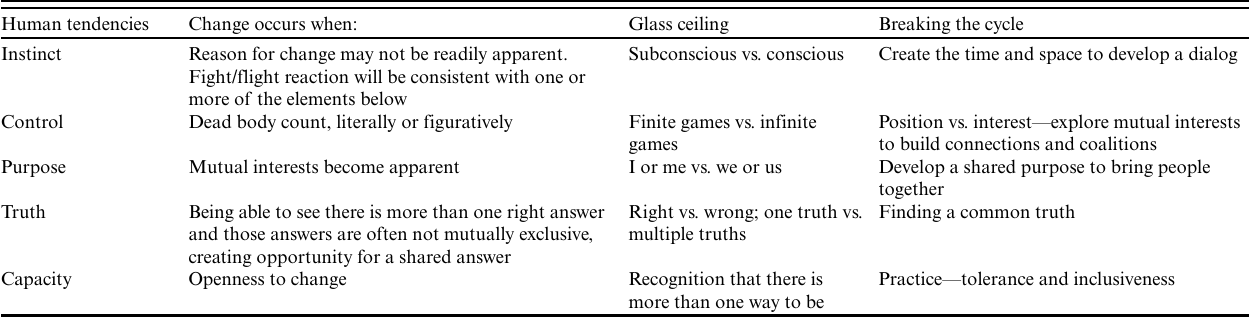
Table 1. Operationalizing elegant conservation requires an ability to see when opportunity for change exists, what the barrier or glass ceiling is that prevents change, and skill in breaking the cycle that keeps one from